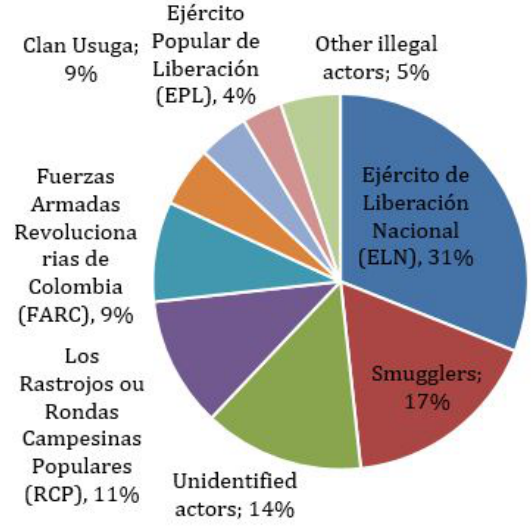
Figure 1. VNSAs in the Colombia and Venezuela Borders. Source: Elaborated by the authors, based on data from selected newspaper